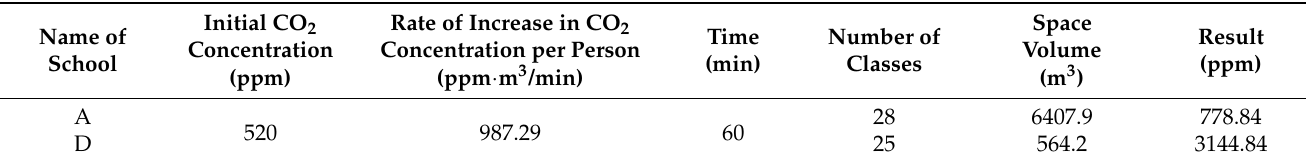
Table 14. CO 2 concentration during badminton activities for 1 h in elementary school A and D, calculated using Equation (6).